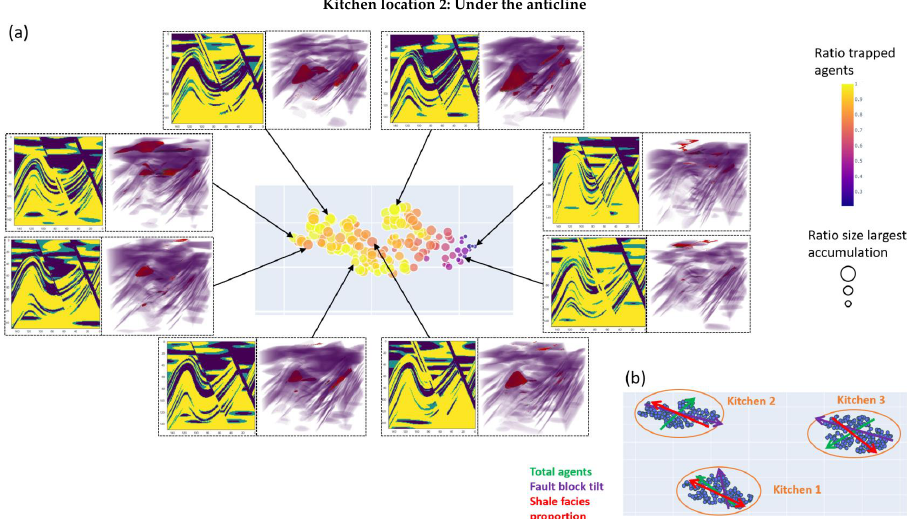
Figure A3. ( a ) t-SNE analysis of kitchen scenario 2 showing the most impactful geological uncertainties and their correlation with simulation evaluation metrics. Each point represents an individual model from the Monte Carlo simulation. The points are colour coded with the evaluation metric ratio of trapped agents and sized by the size of the most significant accumulation. One observation is that accumulations are mainly located in the anticline but a significant part (~25%) is also located in the fault block. Exemplary 2D slices of the environment and 3D plots showing the accumulation positions at the end of the simulation (red) and the barriers (purple) are also shown ( b ) Display of the trends of the original geological parameters with colour coded arrows.